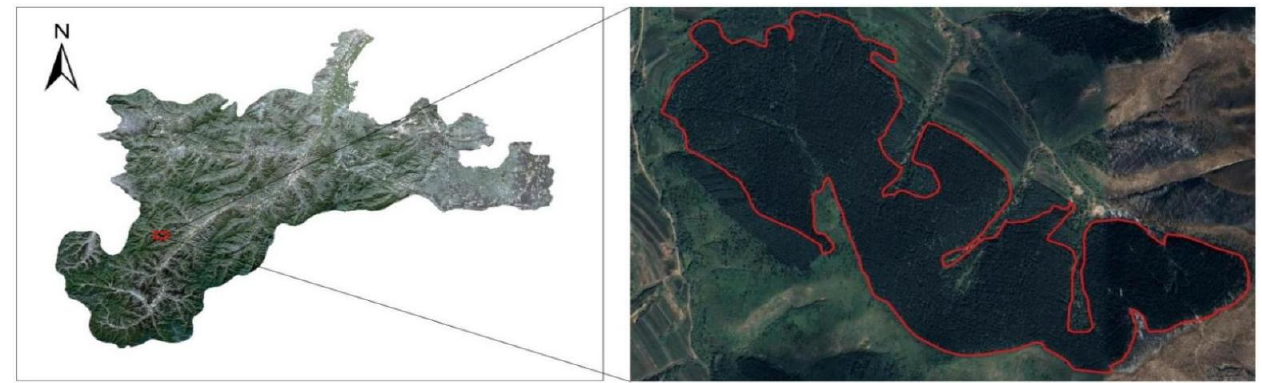
Figure 10. Enlarged view of study area for BI.